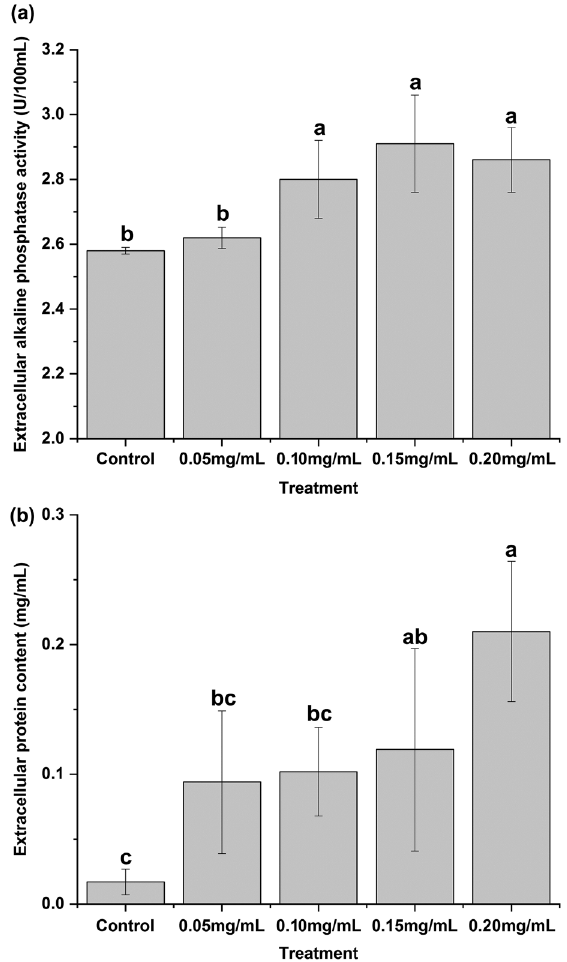
Fig. 3: Release of alkaline phosphatase (AKP; a) and release of soluble protein (b). Control was Clavibacter michiganensis subsp. sepedonicus (Cms) cells treated with 0.80% DMSO. Data were expressed as the mean ± standard deviation of three technical replicates (three tests using the same extract). Different letters represented significant differences ( P <0.05).